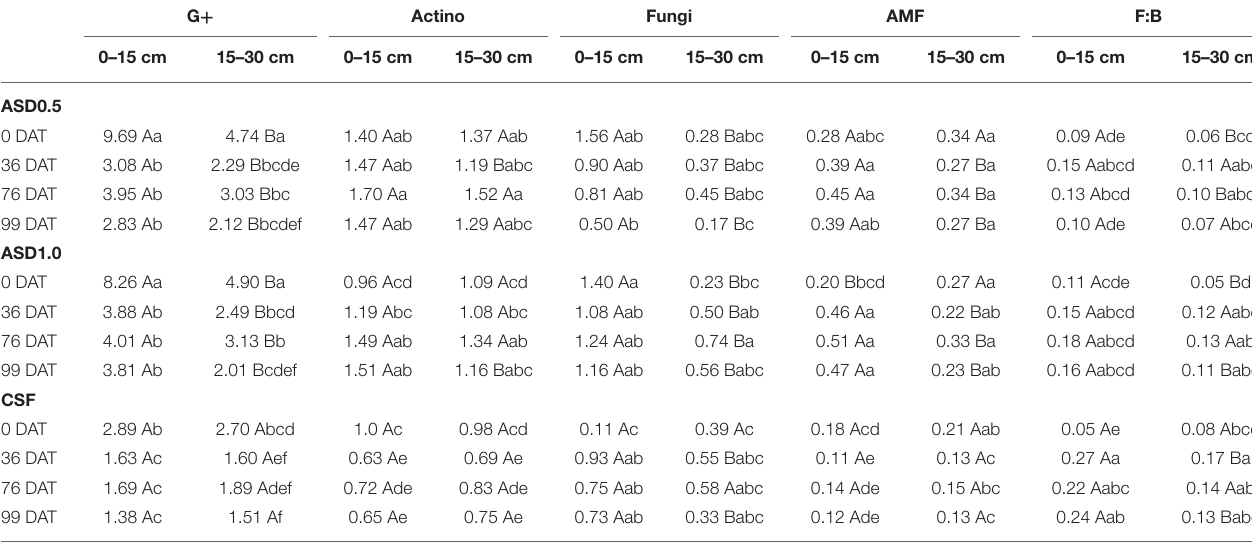
TABLE 2 | Microbial biomarker concentrations (nmol g − 1 ) and ratio of fungi:bacteria in the bulk soil as affected by the three-way interaction of soil treatment, sampling date, and soil depth. G + Actino